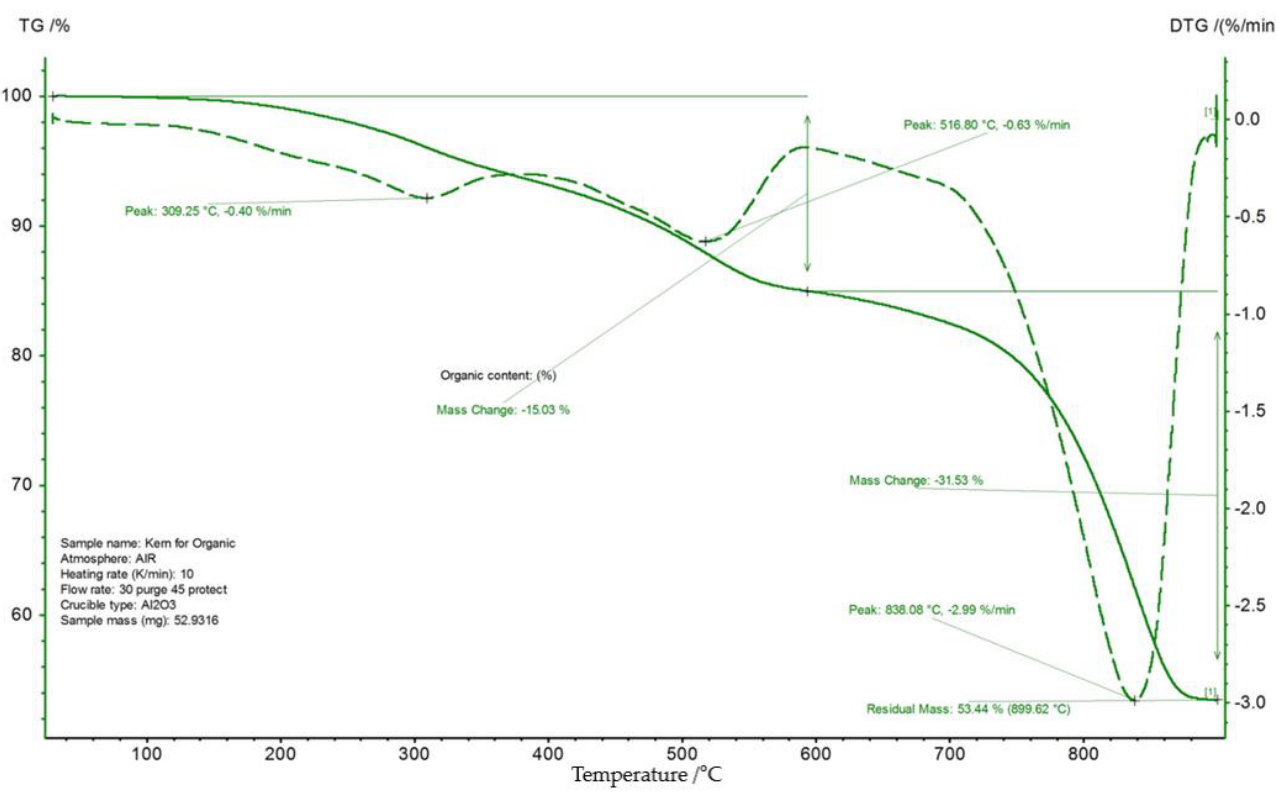
Figure 7. Thermogram of the original